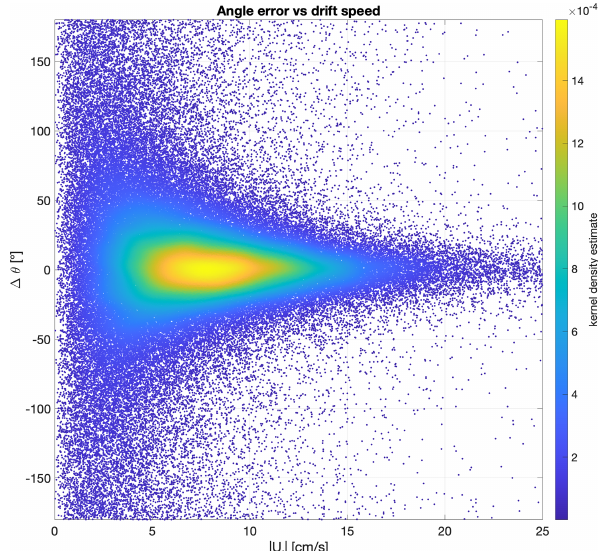
Figure 7. Error on the direction of the drift as a function of the IABP buoy drift speed, for the thickness-dependent parameteriza- tion α h . The error is taken as the angle between the direction of the free-drift estimate and the direction of the buoy drift, for all data available over the 1979–2019 period. The drift angle error takes a value between + 180 ◦ (free drift is to the left of the buoy drift) and − 180 ◦ (free drift is to the right of the buoy drift). The color scale represents the kernel density estimate, an indicator of the density of points in the